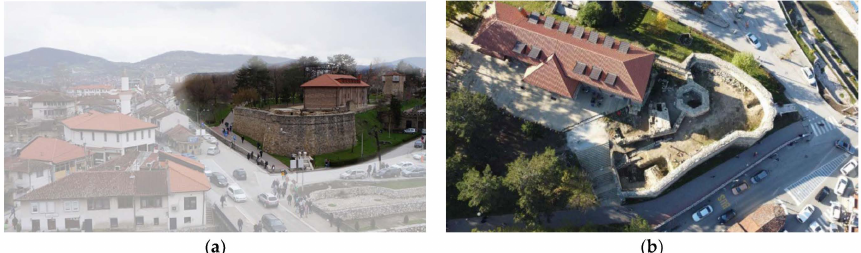
Figure 3. Northern Tabia ( a ) Tower Motrilja (Photo and design: Lejla Ze´cirovi´c). ( b ) Modern-day City Library (Photo source: private archive of Vladan Vidosavljevi´c).